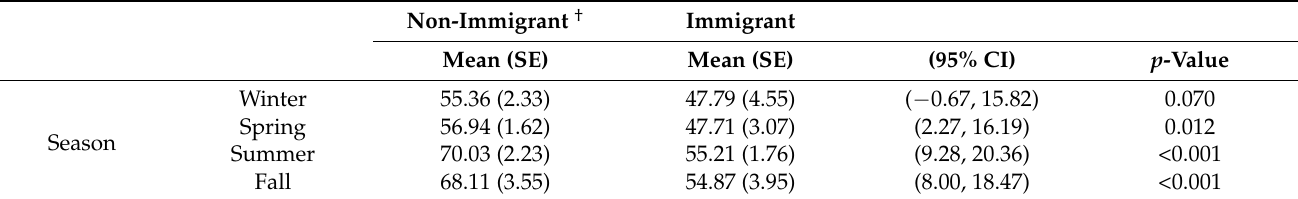
Table A6. Weighted mean S-25(OH)D concentrations (nmol/L) by immigration status and season using Cycles 3 and 4 of Canadian Health Measures Survey data.